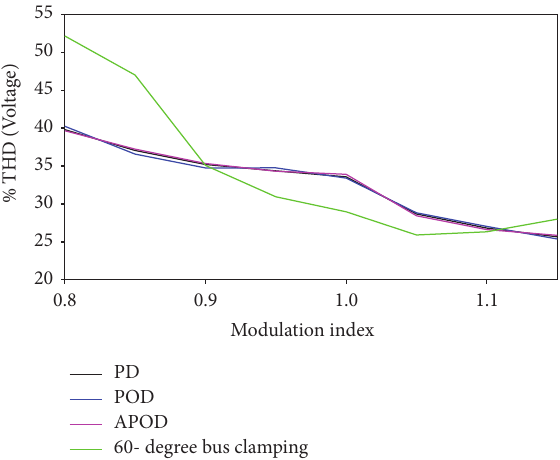
Figure 15: Harmonic distortion in output phase voltage at different modulation indices.